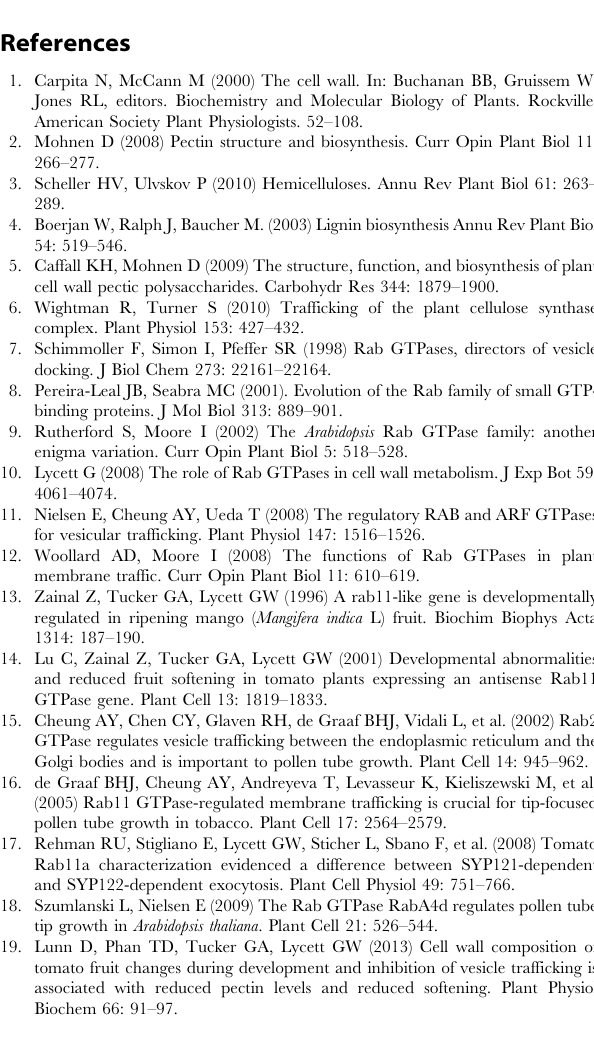
Figure S1 Confirmation of gene transcript absence by RT-PCR analysis of rabA1 T-DNA knockout lines. Expected size fragments for each reaction are shown in table S2.